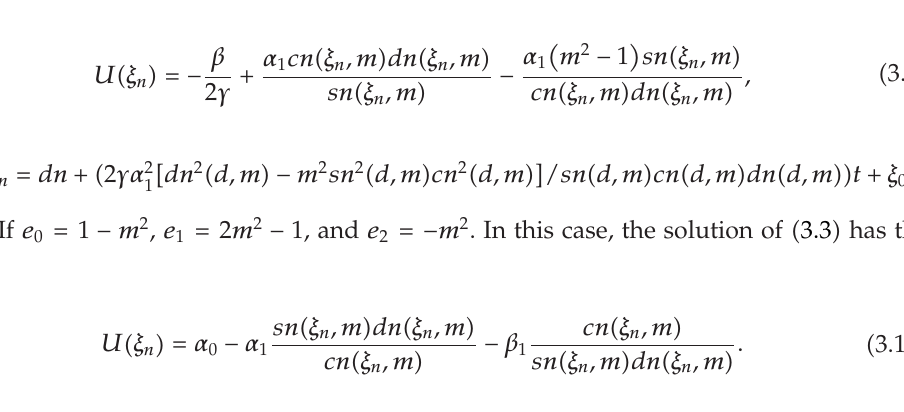
(cid:9) 1 . 5, d (cid:9) 0 . 3, t (cid:9) 2. 1